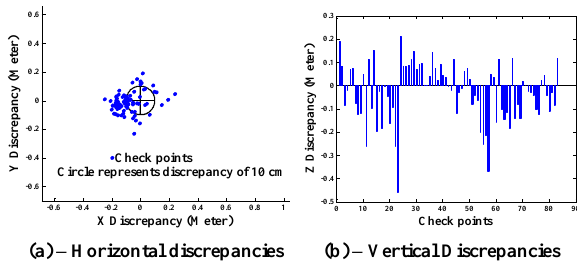
Figure 4. Horizontal e vertical discrepancies of check points (first block) from ISO experiment without control points and IOP from in situ calibration